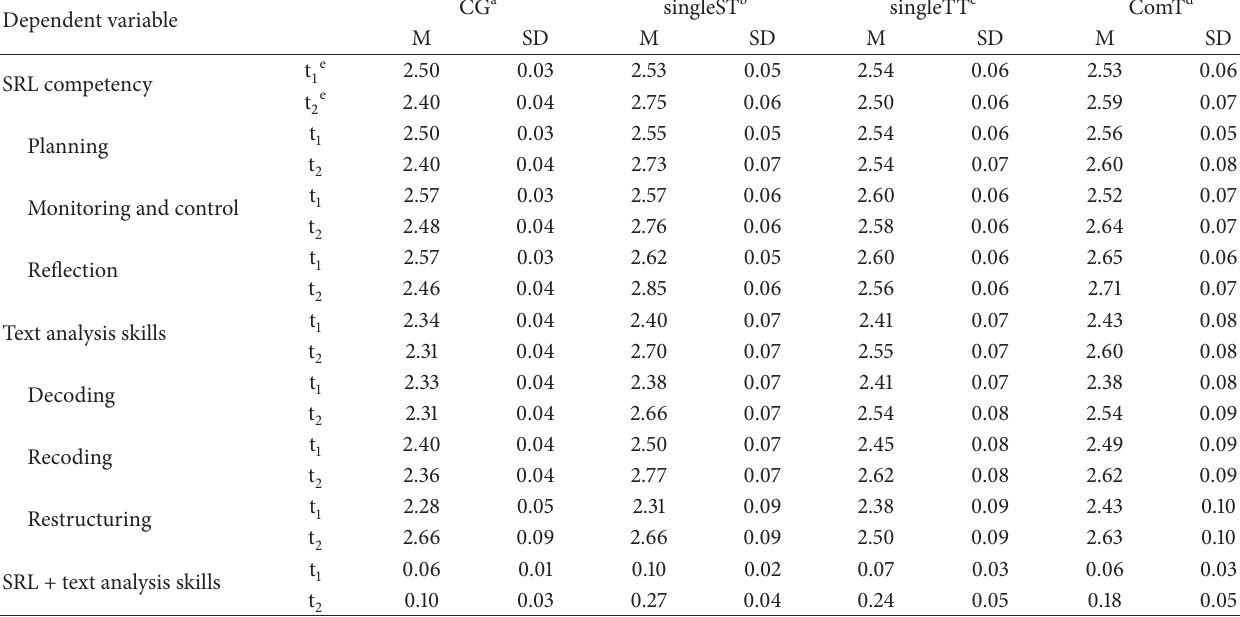
Table 4: Means and standard deviations for self-regulated learning competency (overall), planning, monitoring and control, reflection, text analysis skills (overall), decoding, recoding, restructuring, and the intersection of self-regulated learning competency and text analysis skills and t for the four groups at pre- and posttests (t 1 2